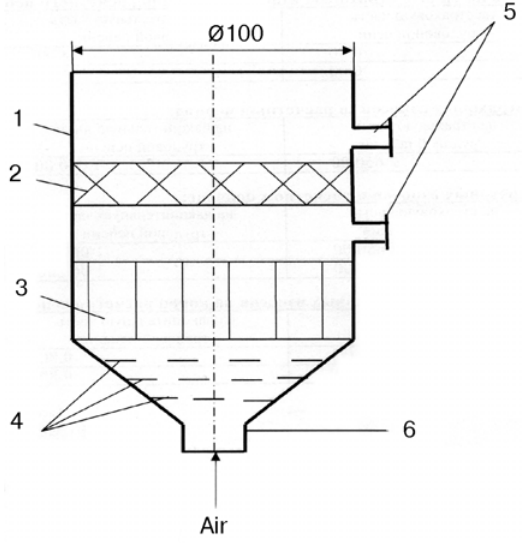
Рис. 4. Опытный аппарат: 1 – корпус; 2 – блок ВПЯМ; 3 – хонейкомб; 4 – решетки; 5 – патрубки отбора ста- Fig. 4. Experimental apparatus: 1 – body; 2 – block high porosity material; 3 – xonecomb; 4 – grid; 5 – branch of static pressure; 6 – entering